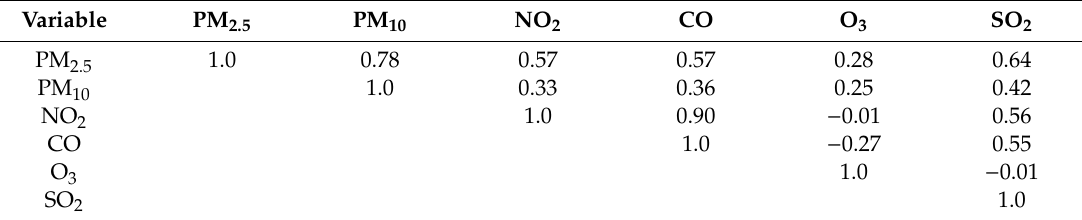
Table 2. Pearson correlation coe ffi cients among air pollutants.